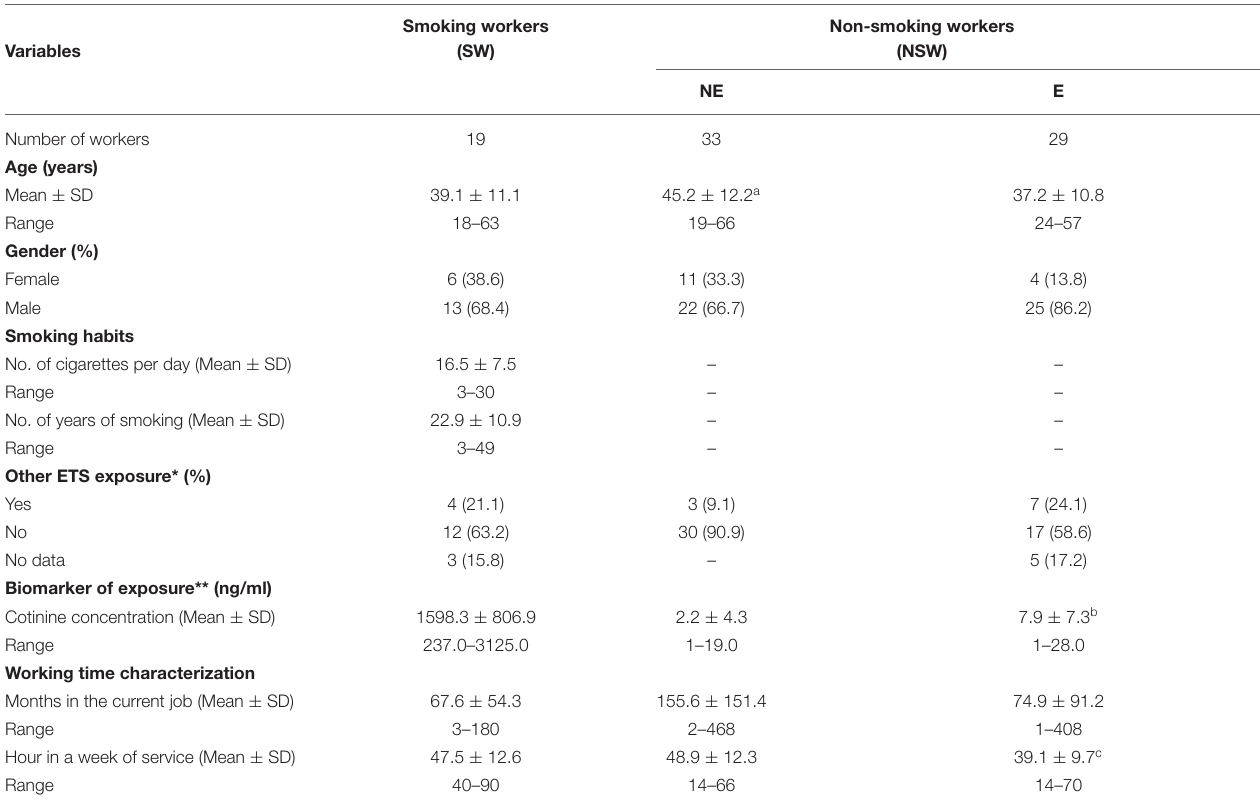
TABLE 1 | Characteristics of the study population.